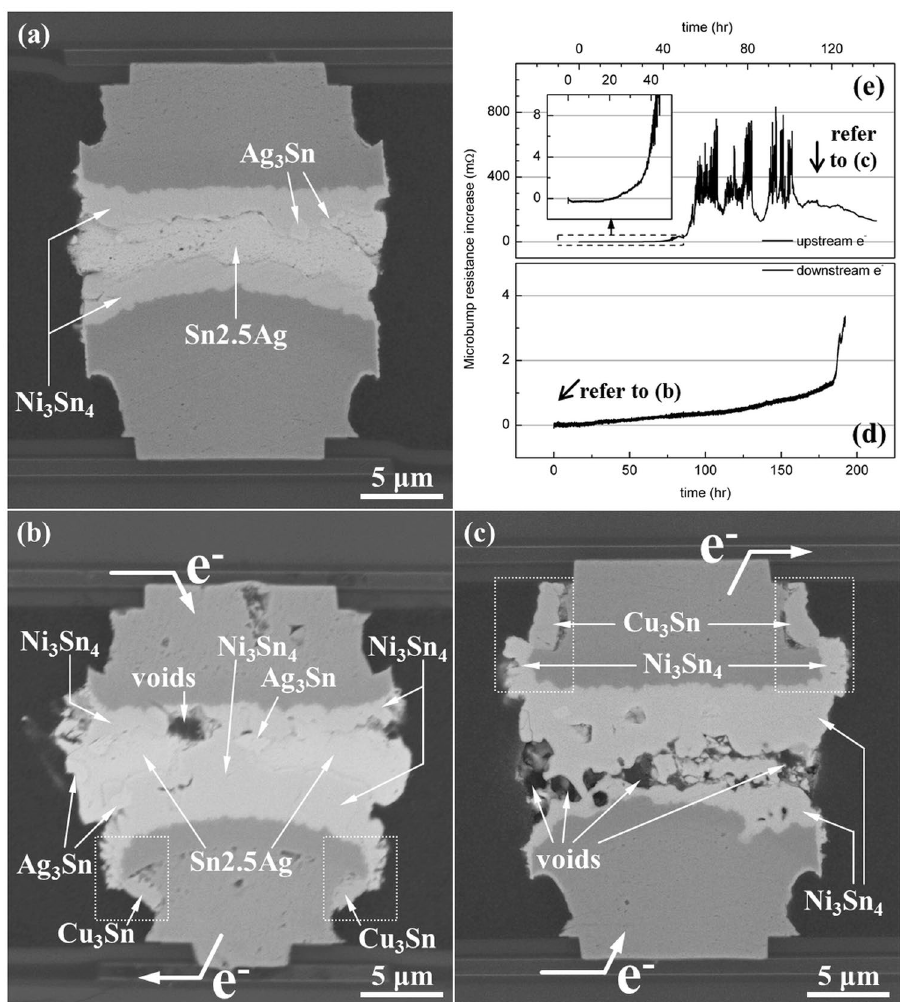
Figure 2. ( a ) The SEM images of the dummy 18- µ m microbump suffered from the same thermal history as the current stressed bumps. Only IMC thickening was observed. After EM tested under 9.2 × 10 4 A/cm 2 at 150 °C, side diffusion took place in microbumps. ( b ) With slight side-diffusion of Sn and ( c ) With severe void formation and failure caused by side-diffusion Sn; ( d ) The resistance curve for the microbump in ( b ), and ( e ) The resistance for the microbump in ( c ), which indicates the failure under EM